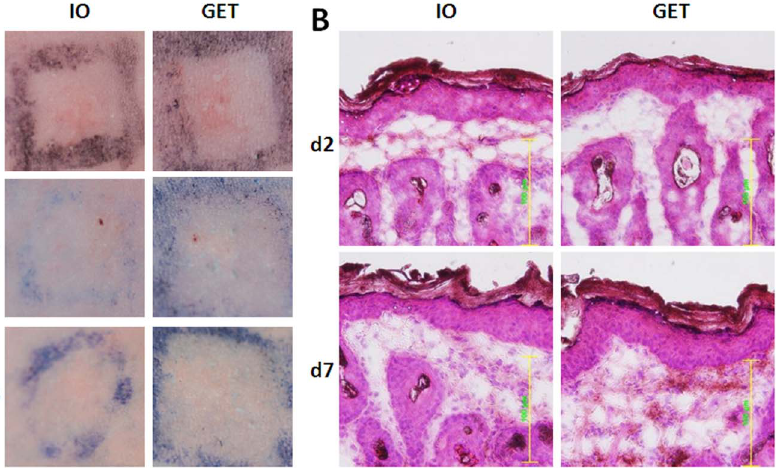
Figure 3. Gross observation and histology of HLGP skin after i.d. DNA injection and non-invasive GET. A , Skin observation after delivery. Pictures were taken at post-delivery day 1, day 5 and day 8. One representative picture of 4 to 6 sites was shown here. Delivery group, IO: 50 m L DNA without pulse delivery; GET: 50 m L DNA with pulse delivery. B , H&E stained skin samples. One representative of 3 treated sites was presented here for post-delivery day 2 or day 7 (magnification =200, scale bar=100 m m).